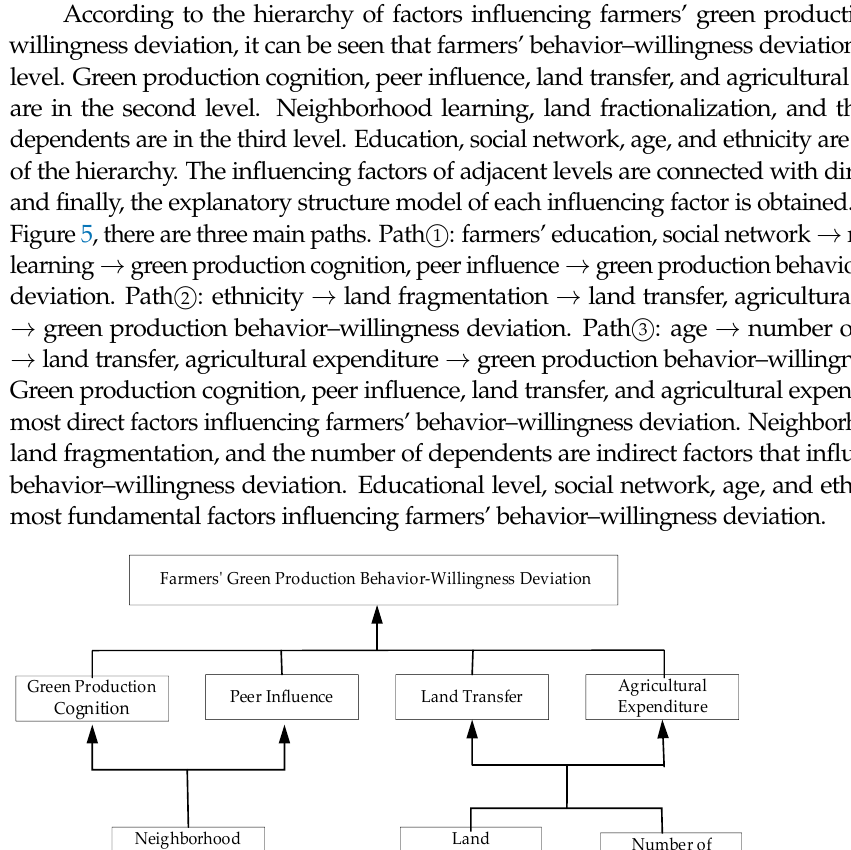
Figure 4. Driving factor hierarchy T diagram.